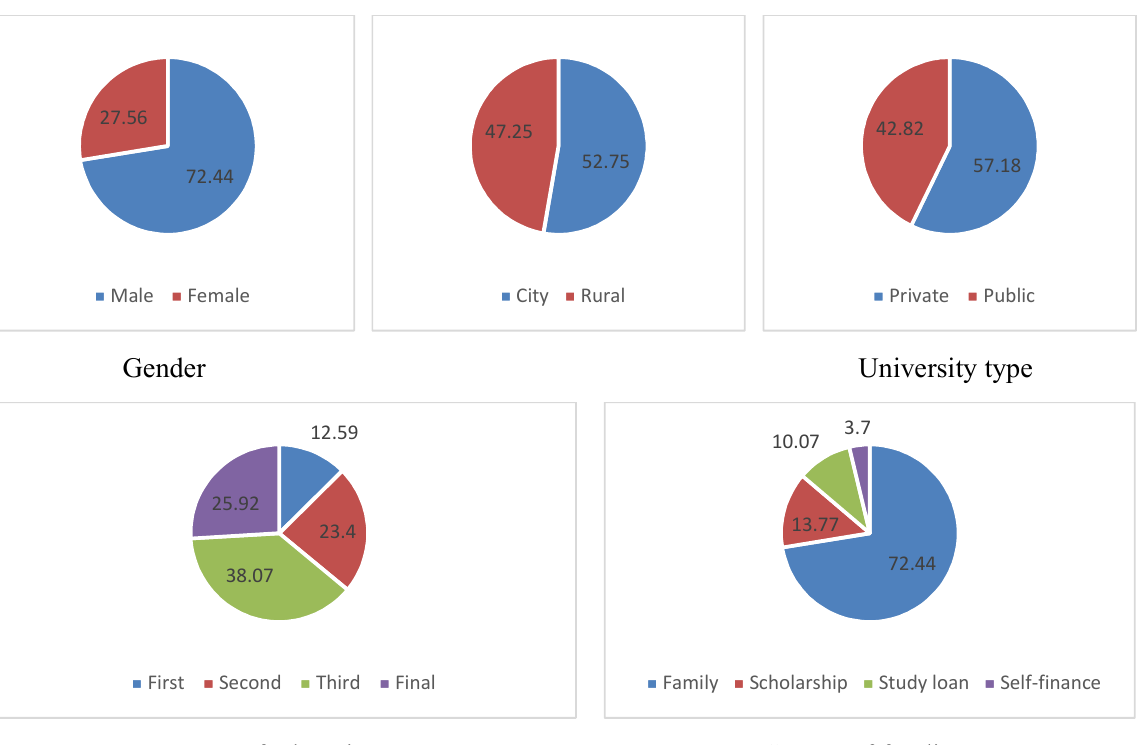
Fig. 2. Personal characteristics of the